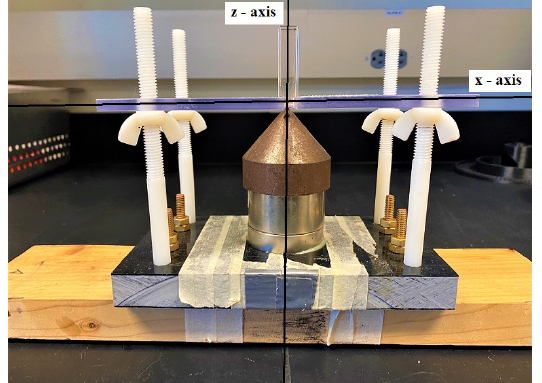
Figure 1. Magnetic apparatus is shown here with corresponding z -axis and x -axis lines. The cuvette sits on top in a fitted dugout, shown behind the z -axis line. The bottom of the cuvette meets the magnetic tip at the origin. The magnetic tip was used to generate a downward pulling magnetic force onto the magnetic nanoparticle (MNP)